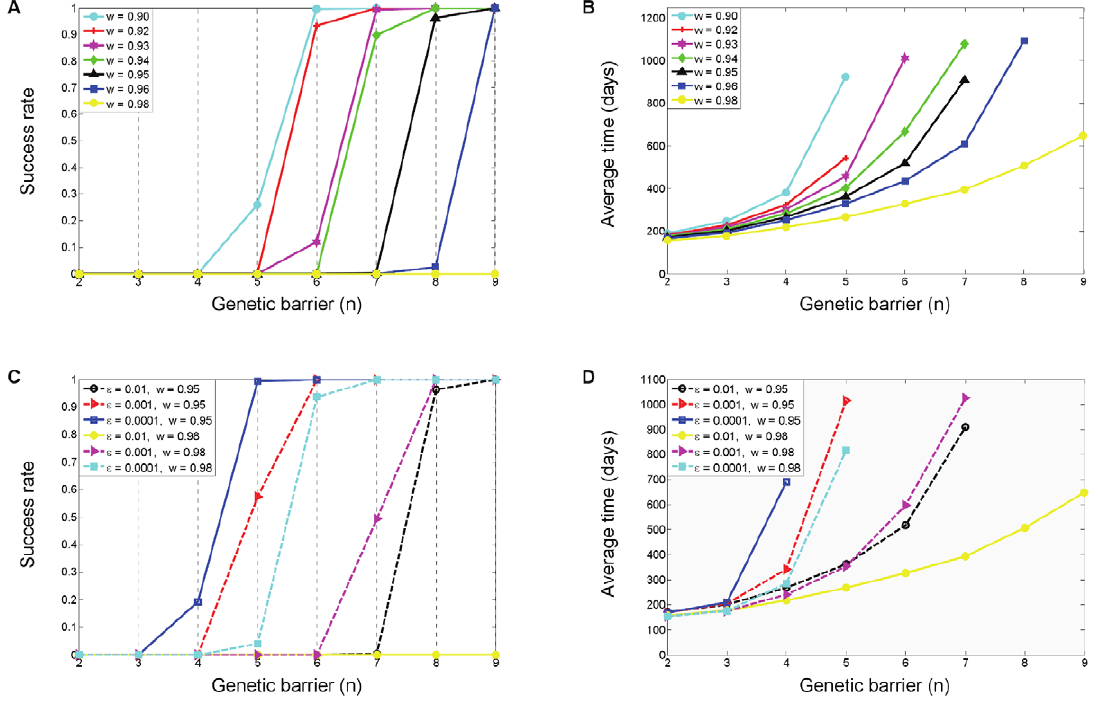
Figure 5. Effects of altering the fitness cost and the inhibition potency on therapy efficacy. Success rates (fractions of successful treatments) and average fixation times are shown as functions of the genetic barrier n (x-axis) for a range of mutational fitness costs w (A,B) and for a range of inhibition factors e (C,D). The data summarize the outcomes of 500 simulation runs per each parameter set, similar to Figure 4. In each panel, different colors are used to depict different parameter values, with black depicting the default case. The plots demonstrate that increasing the fitness cost (lowering w ) and decreasing the inhibition factor e both result in prolonged viral suppression. This is manifested in improved success rates and in delayed resistance emergence. Panels C and D depict the effects of varying the inhibition factor for two distinct fitness costs ( w ~ 0 : 95, 0 : 98 ), illustrating the tradeoff between the two factors. It can be seen that a tenfold increase in inhibition ( e ~ 0 : 01 ? e ~ 0 : 001 , w ~ 0 : 98 ) is as effective as a slight decrease in fitness cost ( e ~ 0 : 01 , w ~ 0 : 98 ? w ~ 0 : 95 ). Panels C and D also point out that minor fitness costs (e.g., w ~ 0 : 98 ) must be compensated by powerful inhibition ( e ƒ 0 : 001 ) in order to attain long-term suppression with potentially achievable genetic barriers ( n ƒ 8 ).